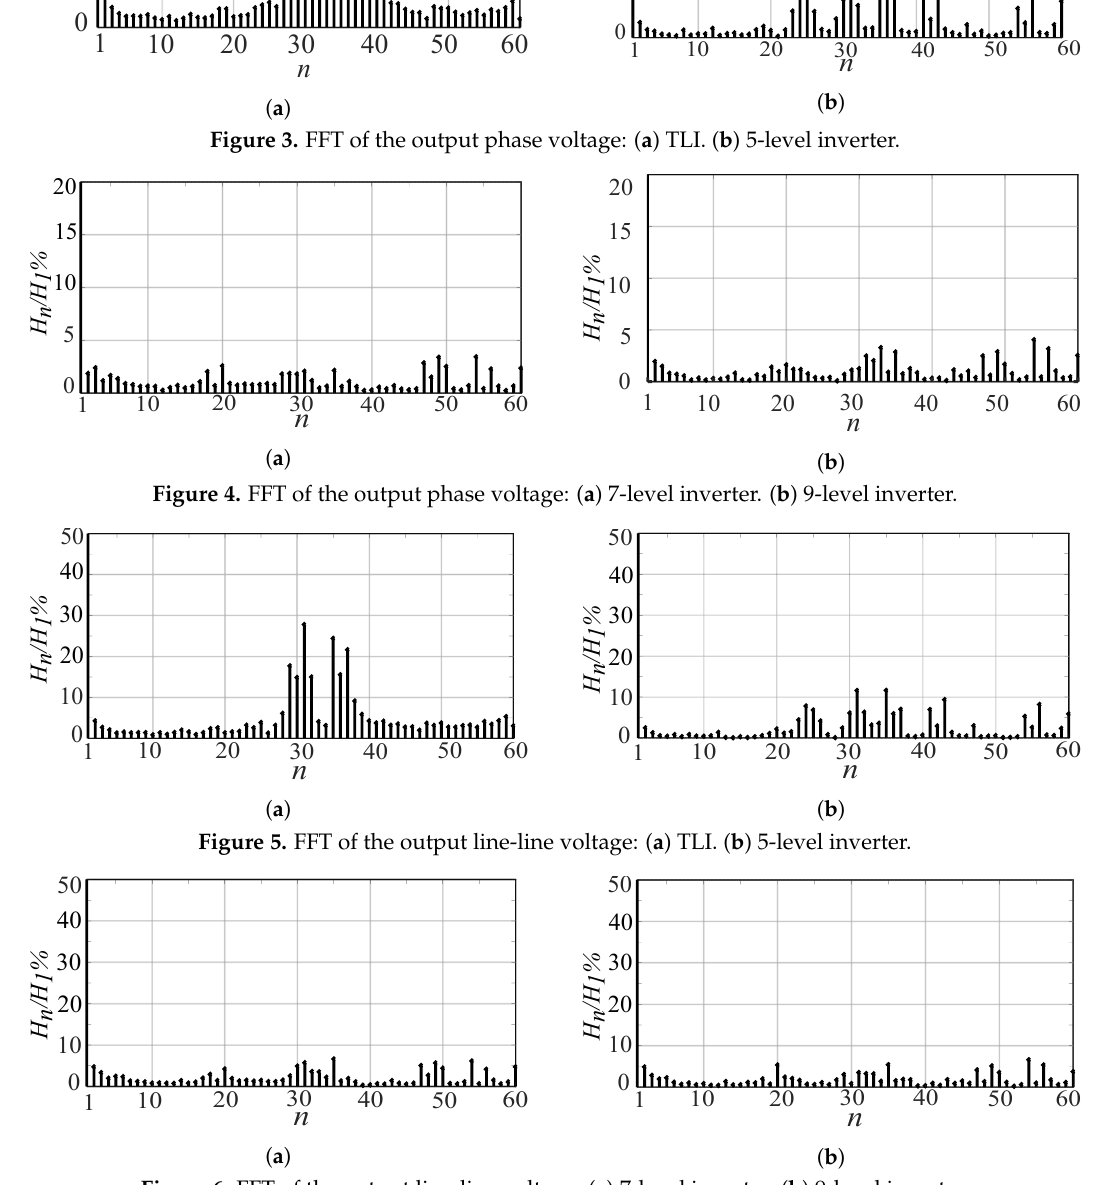
Figure 6. FFT of the output line-line voltage: ( a ) 7-level inverter. ( b ) 9-level